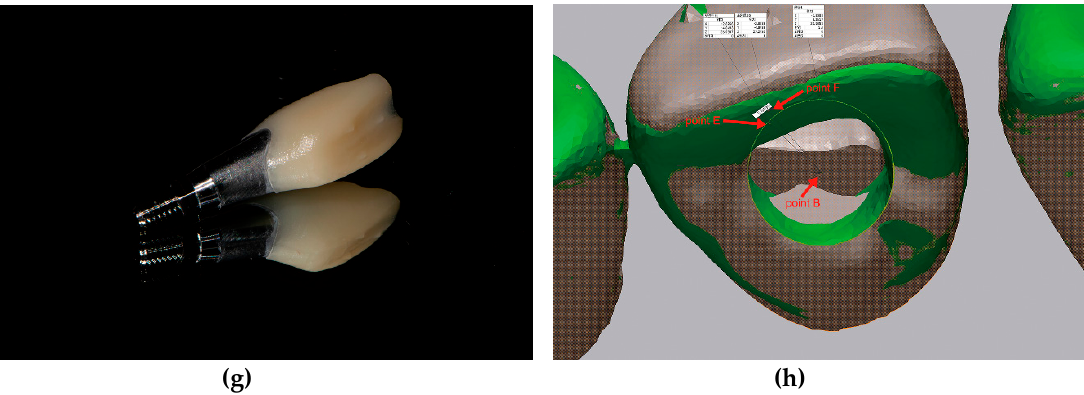
Figure 2. Details of the experimental protocols; ( a ) Maxillary typodont (CIBM01, Osstem, Busan, Korea) with a missing right central incisor; ( b ) Virtual single immediate provisional restoration design in the implant-planning software (Implant Studio version 2.17.1.4, 3Shape, Copenhagen, Denmark) showing three small projections on the labial surface and sufficient clearance from adjacent teeth; ( c ) Determination of implant fixture diameter, length (TS III 4.0 × 10 mm, Osstem, Busan, Korea), and implant position; ( d ) Metal-sleeveless computer-assisted implant surgical guide design for fully guided implant placement; ( e ) Sectioned silicone replica for evaluation of the marginal gap of the provisional restoration using a stereozoom microscope (SMZ168, Motic, Xiamen, China) at 45× magnification and image analysis software (ImageJ version 1.51k, National Institute of Health, Bethesda, MD, USA). The marginal gap was defined by the distance between the two black arrows; ( f ) Measurement of guide hole tolerance in the image-editing software (Photoshop 2018, Adobe, San Jose, CA, USA). The value marked with the red rectangle in the upper menu indicates the tolerance; ( g ) Customized prefabricated screw-type immediate provisional restoration; ( h ) An example image showing the angular deviation, which was defined by the angle formed by lines BE and BF. Point B, the reference point. Points E and F, points of crossing between the perpendicular lines (drawn from the centers of the triangles formed by the three small projections on the provisional restorations in each dataset) and the reference plane.